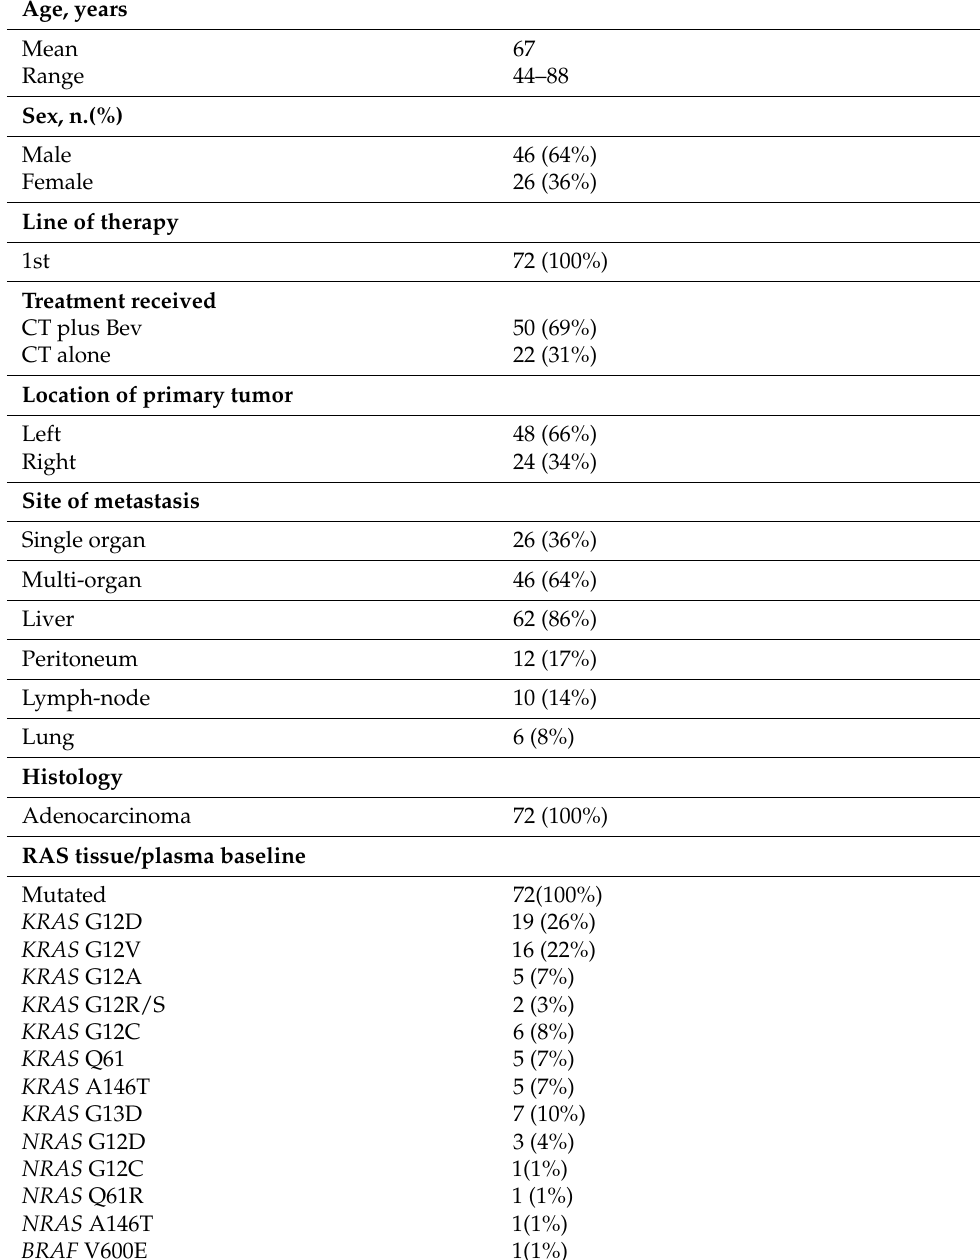
Table 1. Patient’s